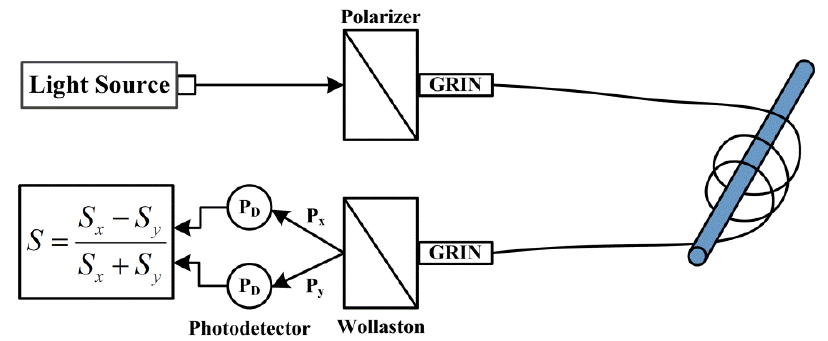
Figure 4. Schematic of the dual-quadrature polarimetric detection incorporating optical fiber links. Legend: GRIN (GRadient INdex); P in polarizations